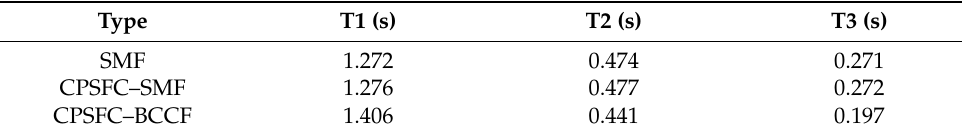
Table 3. Third-order period for each structural Table 3. Third ‐ order period for each structural model.